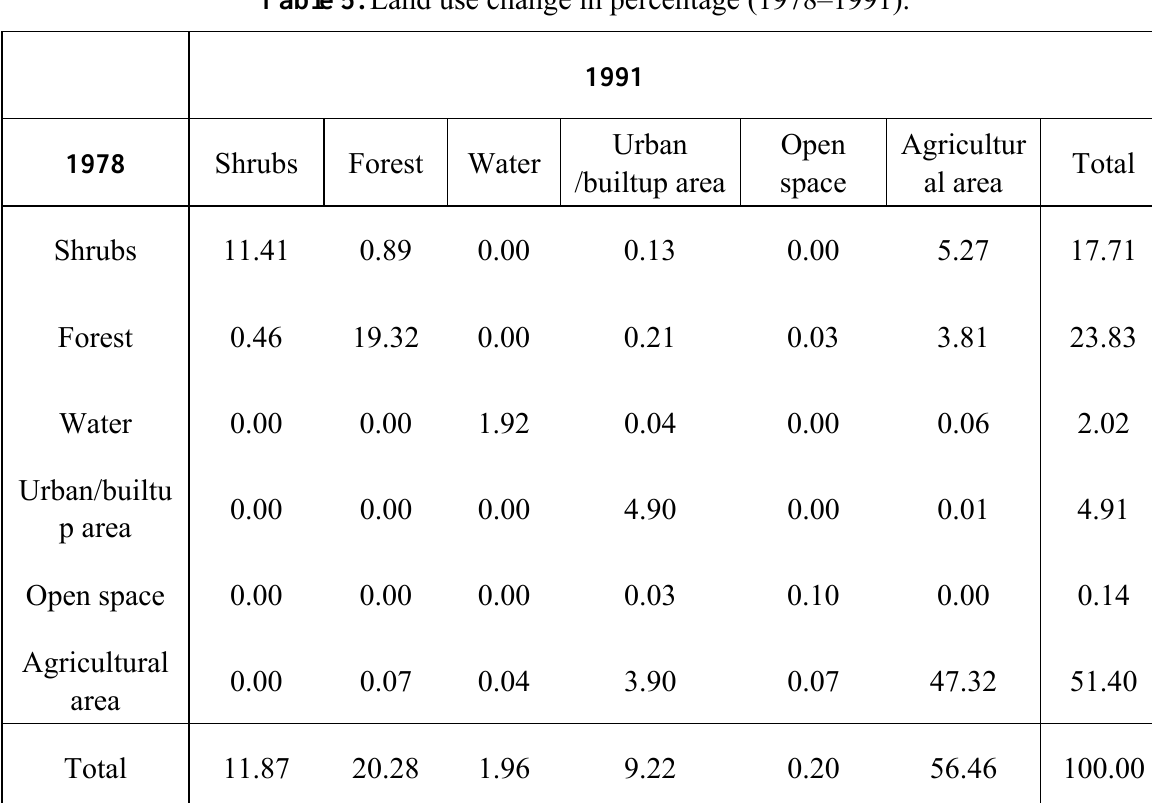
Table 5. Land use change in percentage